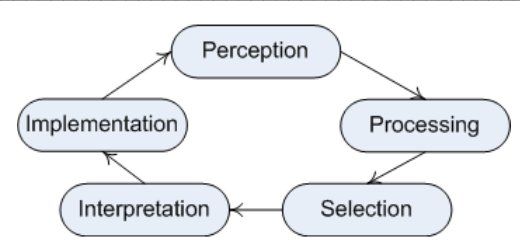
Fig. 1. The affective loop of an intelligent tutoring system evolve by integrating into the traditional intelligent tutoring system ability to recognize student’s emotions and to respond to them in an appropriate way. The modelling of student’s emotions provides two main advantages in tutoring systems [4]:  it allows adaptation of the learning process and environment not only to cognitive characteristics of the student, but also to his/her affective state;  it allows inducing of necessary emotions to the student in order to promote more effective learning.